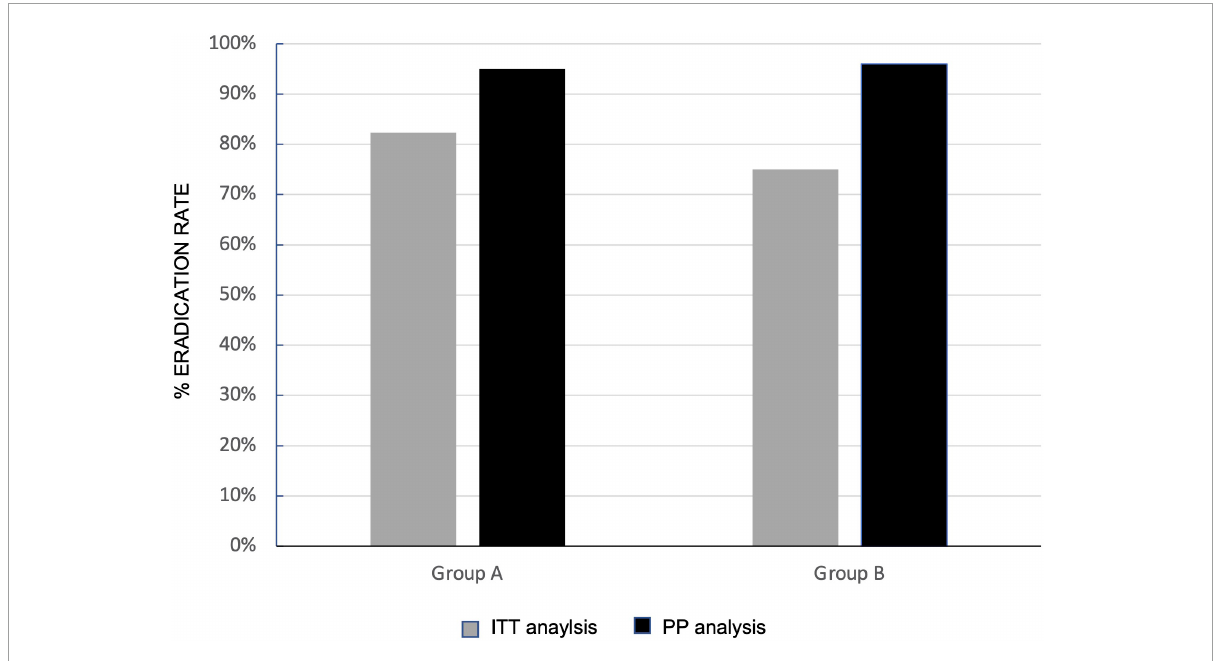
FIGURE3 Effects of Lactobacillus rhamnosus GG (LGG) supplementation in three-in-one bismuth-quadruple therapy (BQT) eradication rates. Eradication rate at intention-to-treat (ITT) (gray column) and per protocol (PP) (black column) in group A (sole BQT treatment) and group B (BQT treatment with LGG supplementation).